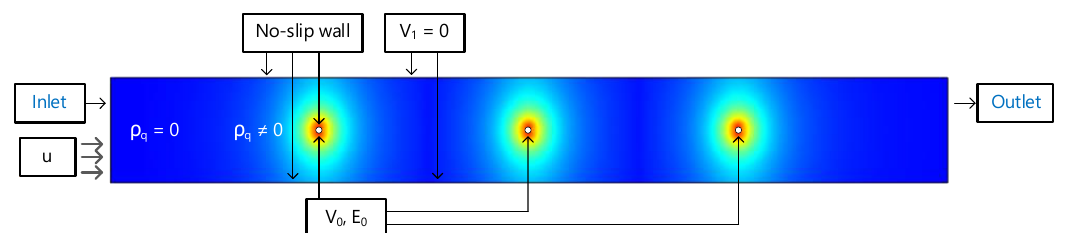
Figure 11. The computational domain of the modeled ESS (the electrodes are not to scale).